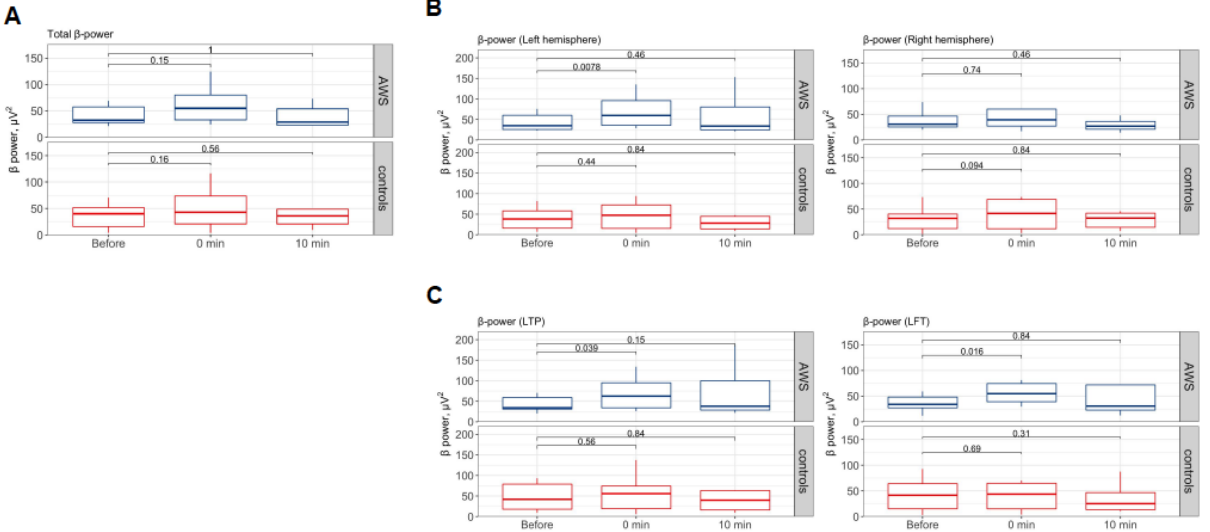
Figure 3. EEG β -power change at the different stages of experiment. ( A ) EEG β -waves in reading experiments in AWS ( top ) and control group ( bottom ) averaged across all 32 electrodes. ( B ) Power in β -band for left and right hemispheres ( left and right , respectively) during the reading activities in AWS and controls. ( C ) Power in β -band averaged across electrode groups located over the LTP junction ( left ) and LFT area during the reading activities in AWS and controls. Abbreviations: EEG — electroencephalography, AWS—adults with stuttering; LTP—left temporoparietal junction; LFT—left frontotemporal area.